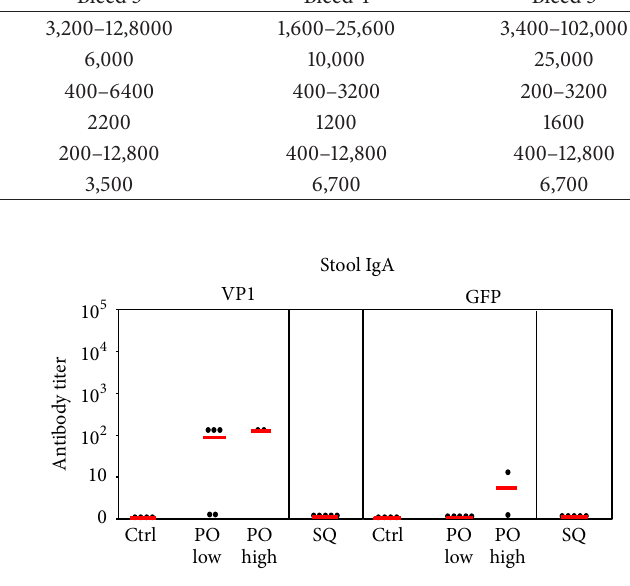
Table 2: Anti-GFP IgG titers, defined as reciprocals of dilutions giving a response twofold above background. Vaccine dosage Bleed 1